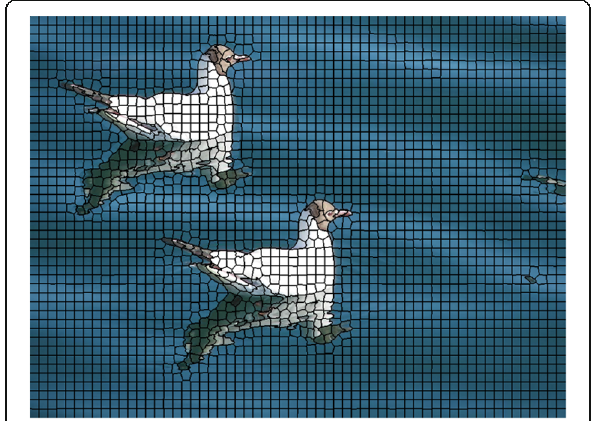
Fig. 1 An example of SLIC segmentation. Every superpixel is approximately the size of 300 pixels